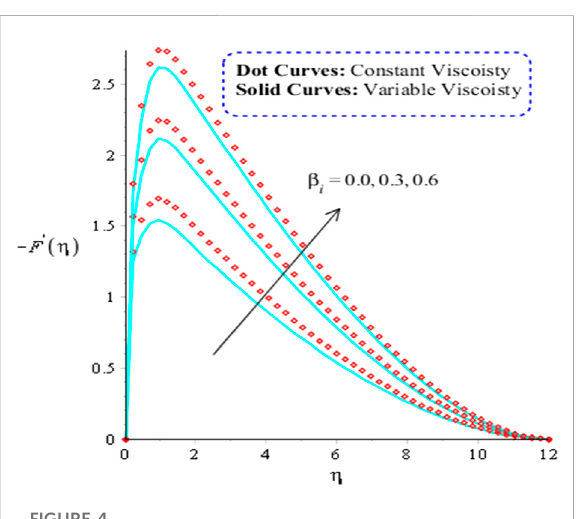
FIGURE 6 Variation in primary velocity fi eld versus β e